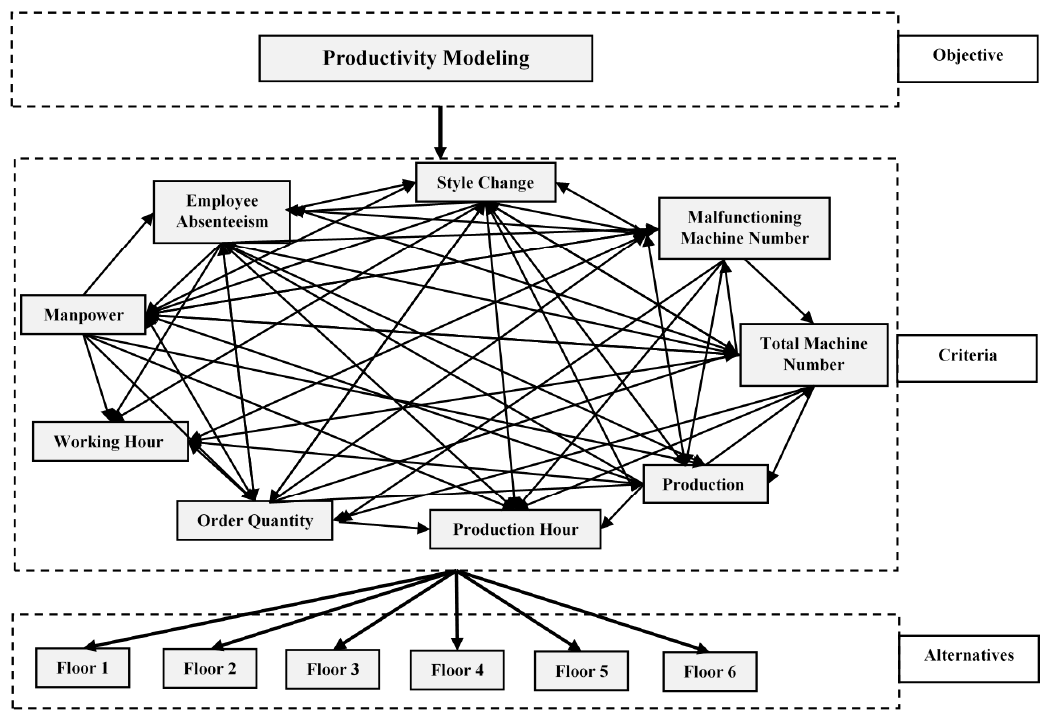
Figure 2. Productivity measurement model using ANP.